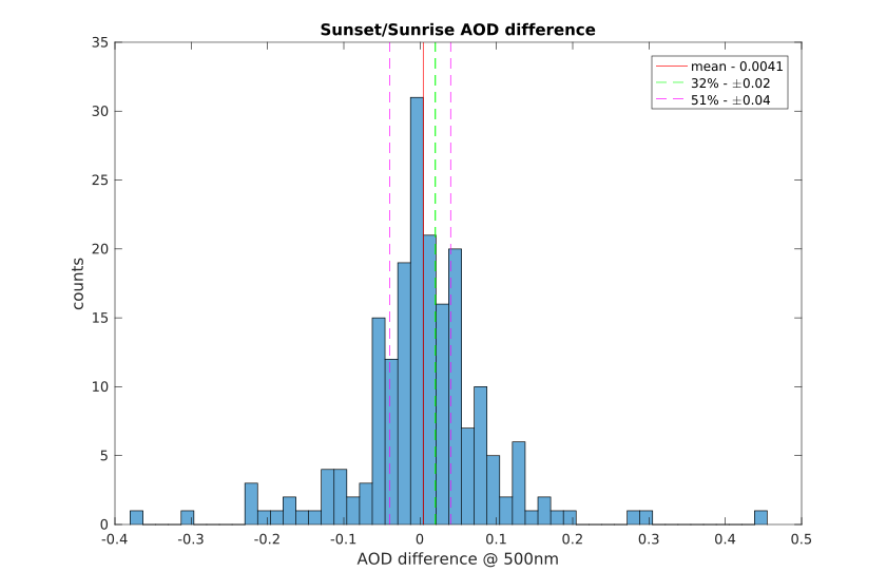
Figure 6. Difference between AOD measurement made by CIMEL-318 before sunset and after sunrise on SolarAOT site (AERONET data